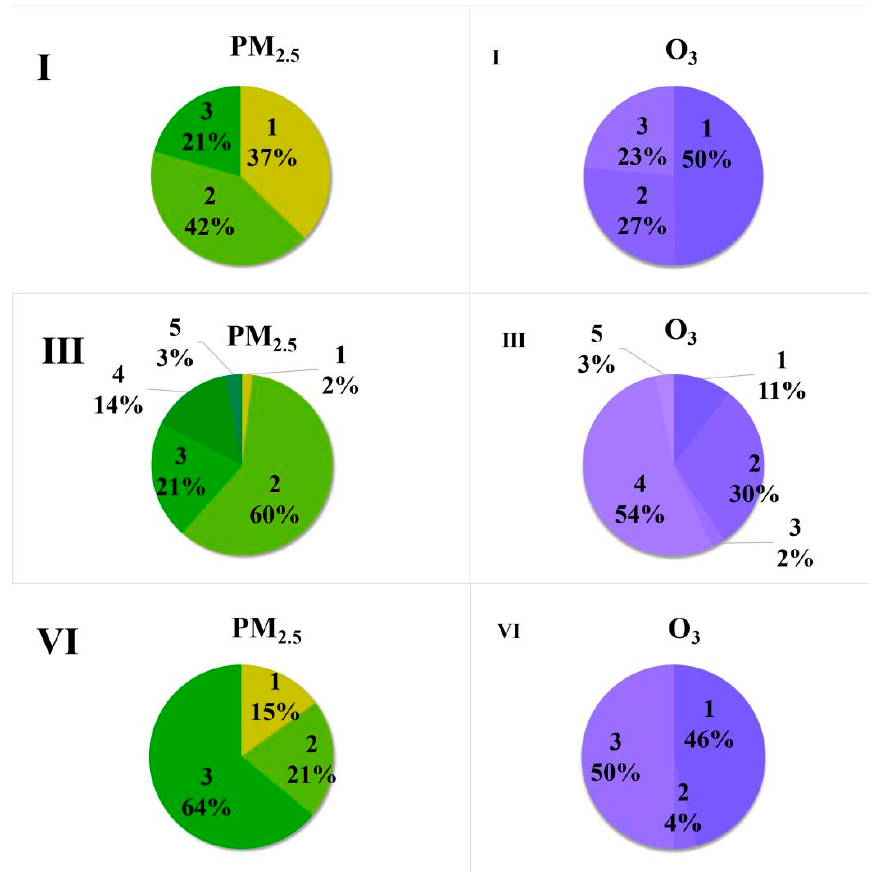
Figure 11. O 3 and PM 2.5 concentration ratios of the clustering trajectory in the pollution processes of I, III, and VI.